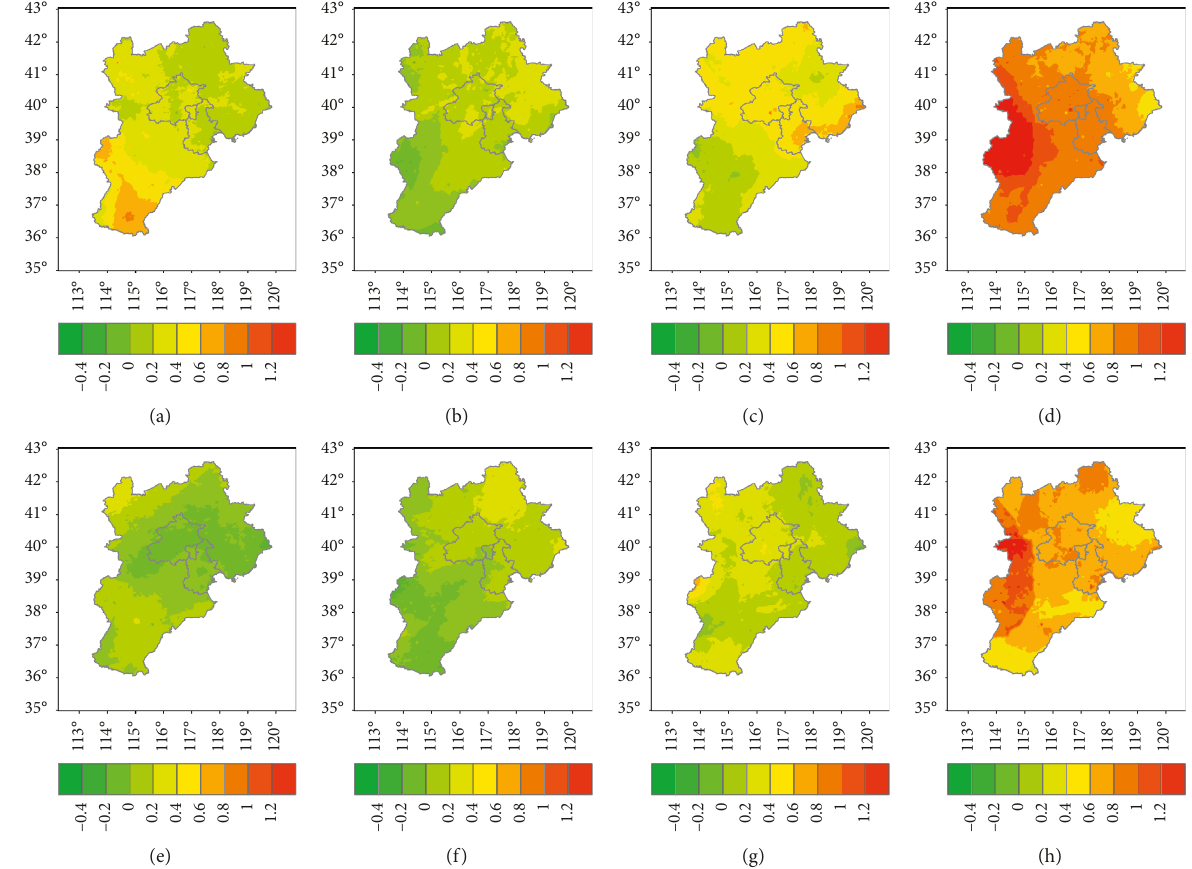
Figure 7: Interdecadal variations in mean temperature in spring and summer over the Beijing-Tianjin-Hebei region: (a) spring T2-T1; (b) spring T3-T2; (c) spring T4-T3; (d) spring T5-T4; (e) summer T2-T1; (f) summer T3-T2; (g) summer T4-T3; (h) summer T5-T4.